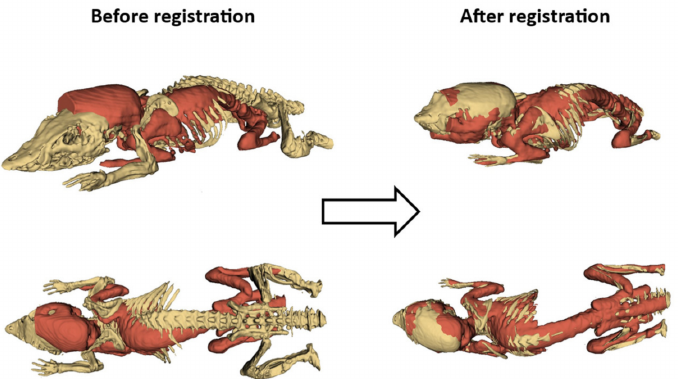
Figure 5. Qualitative registration performance, assessed through the overlapping of standard (yellow) and real (red) bone